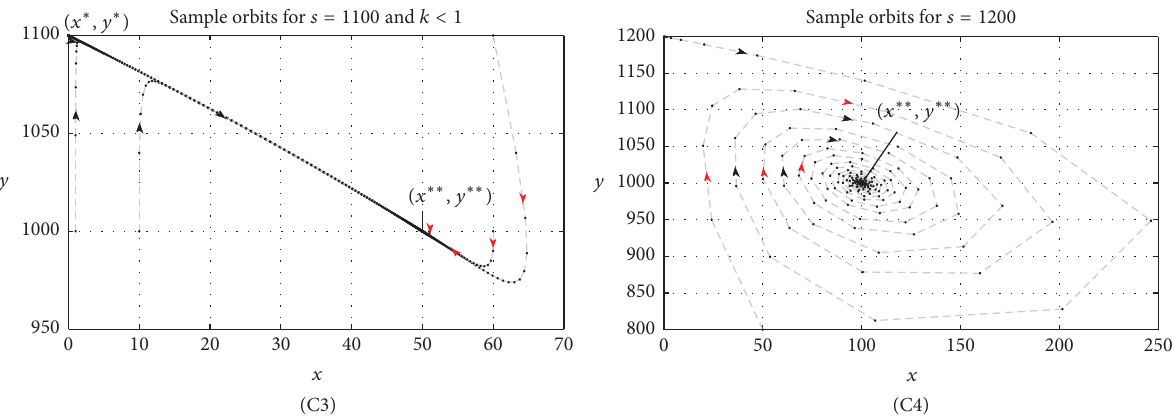
Figure 3: Examples illustrating conditions (C3) and (C4) from Table